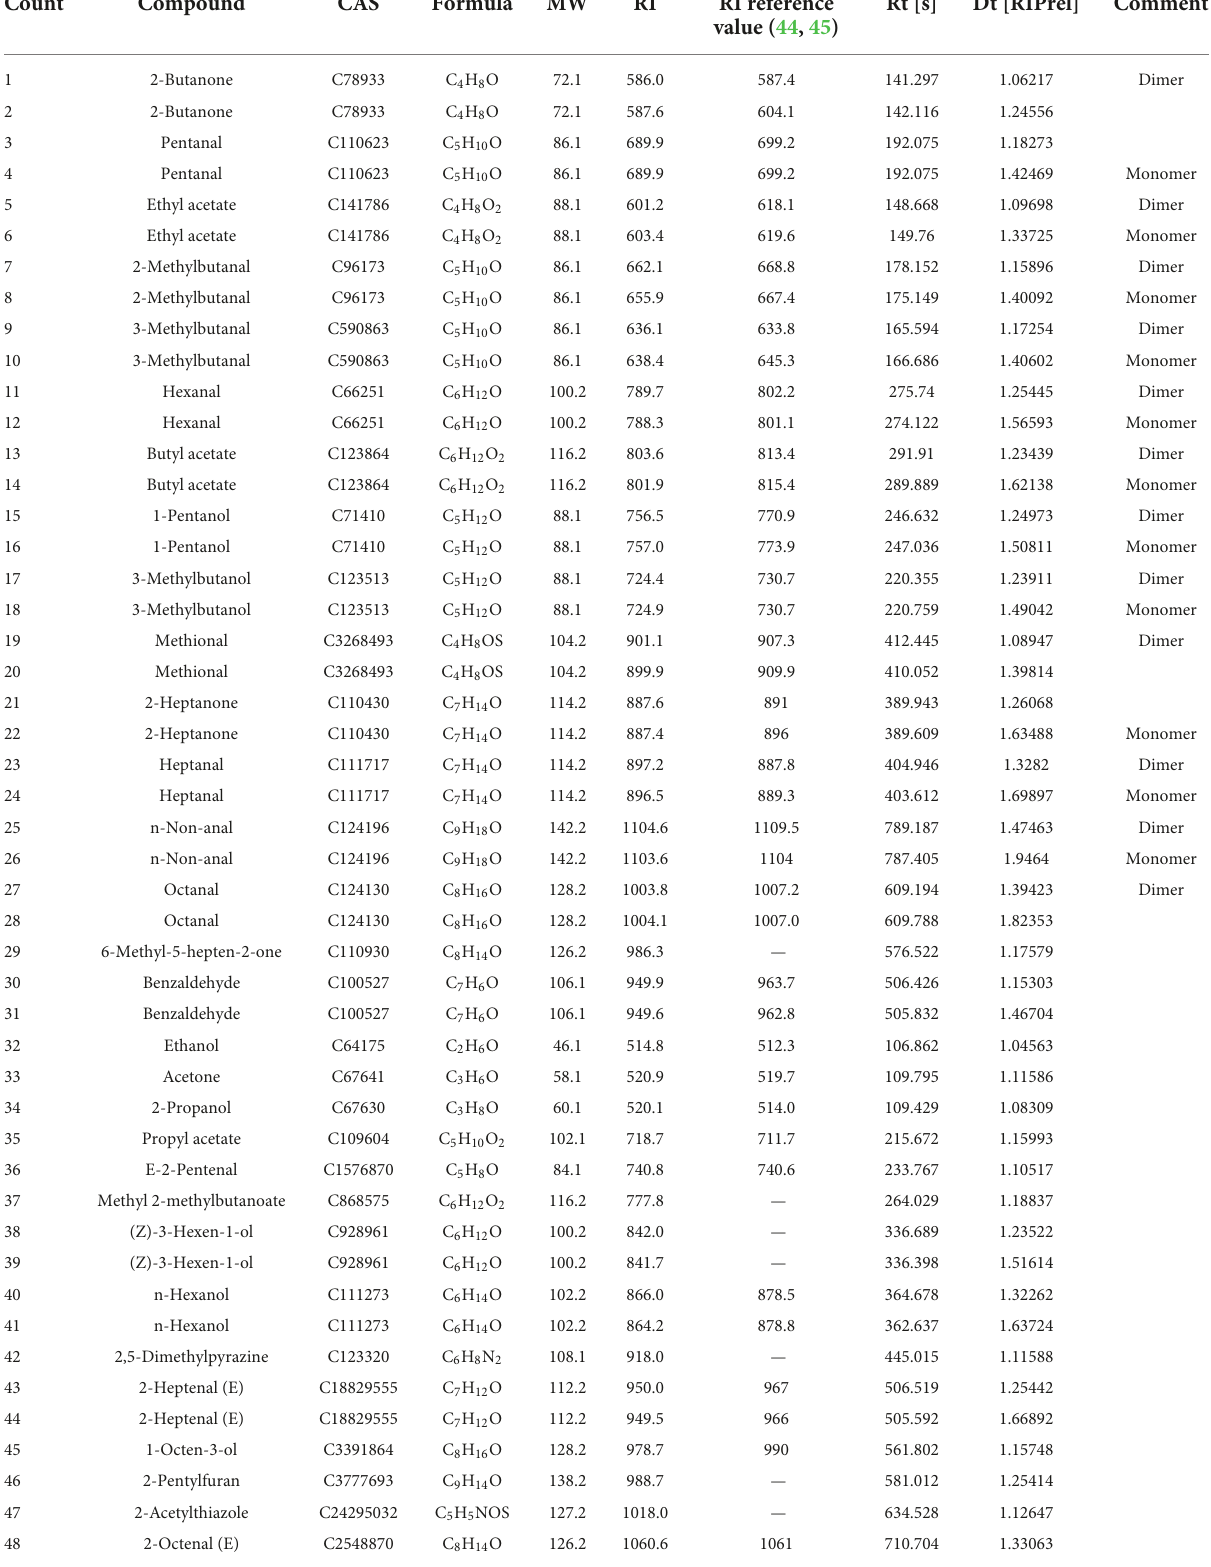
TABLE 4 Qualitative results of GC-IMS of fried crayfish shrimp